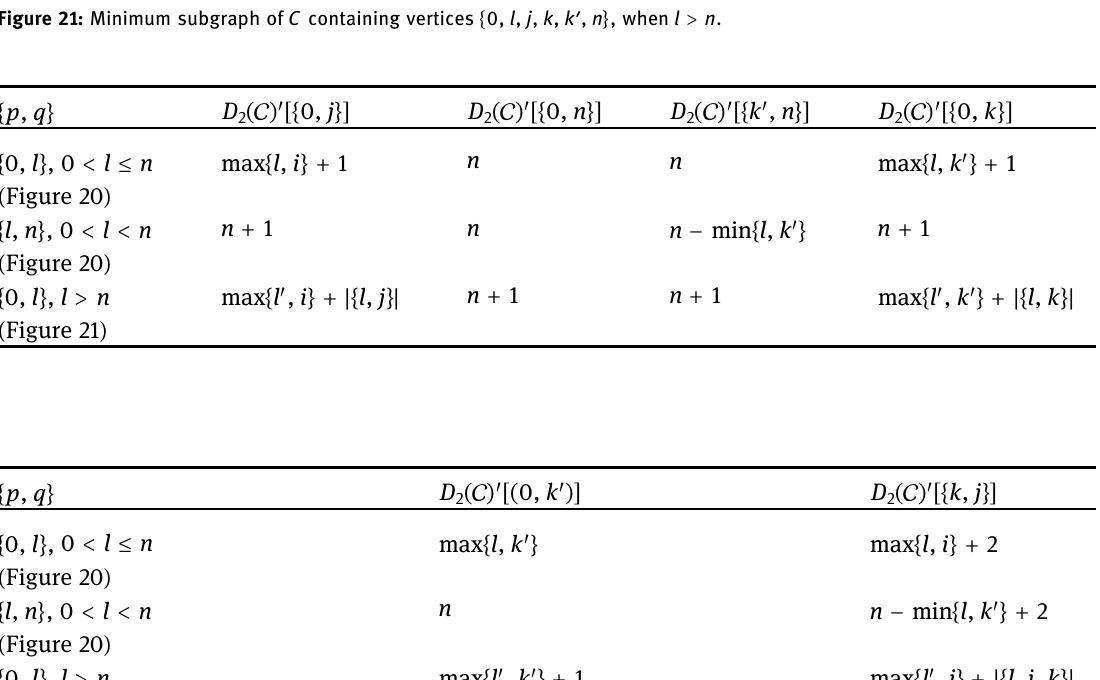
Figure 21: Minimum subgraph of C containing vertices { } l j k k n 0, , , , ′, , when > l n .